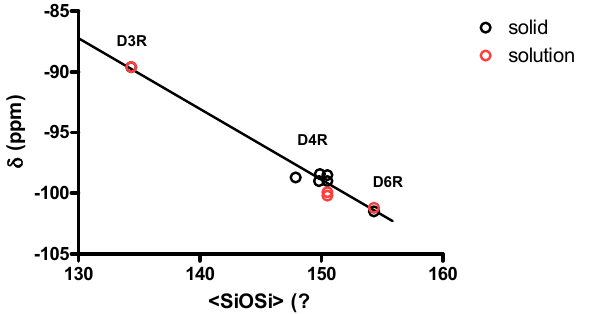
Figure 8. Relation between 29 Si chemical shift and mean SiOSi angle for Q 3 Si in silicate cages D n R.